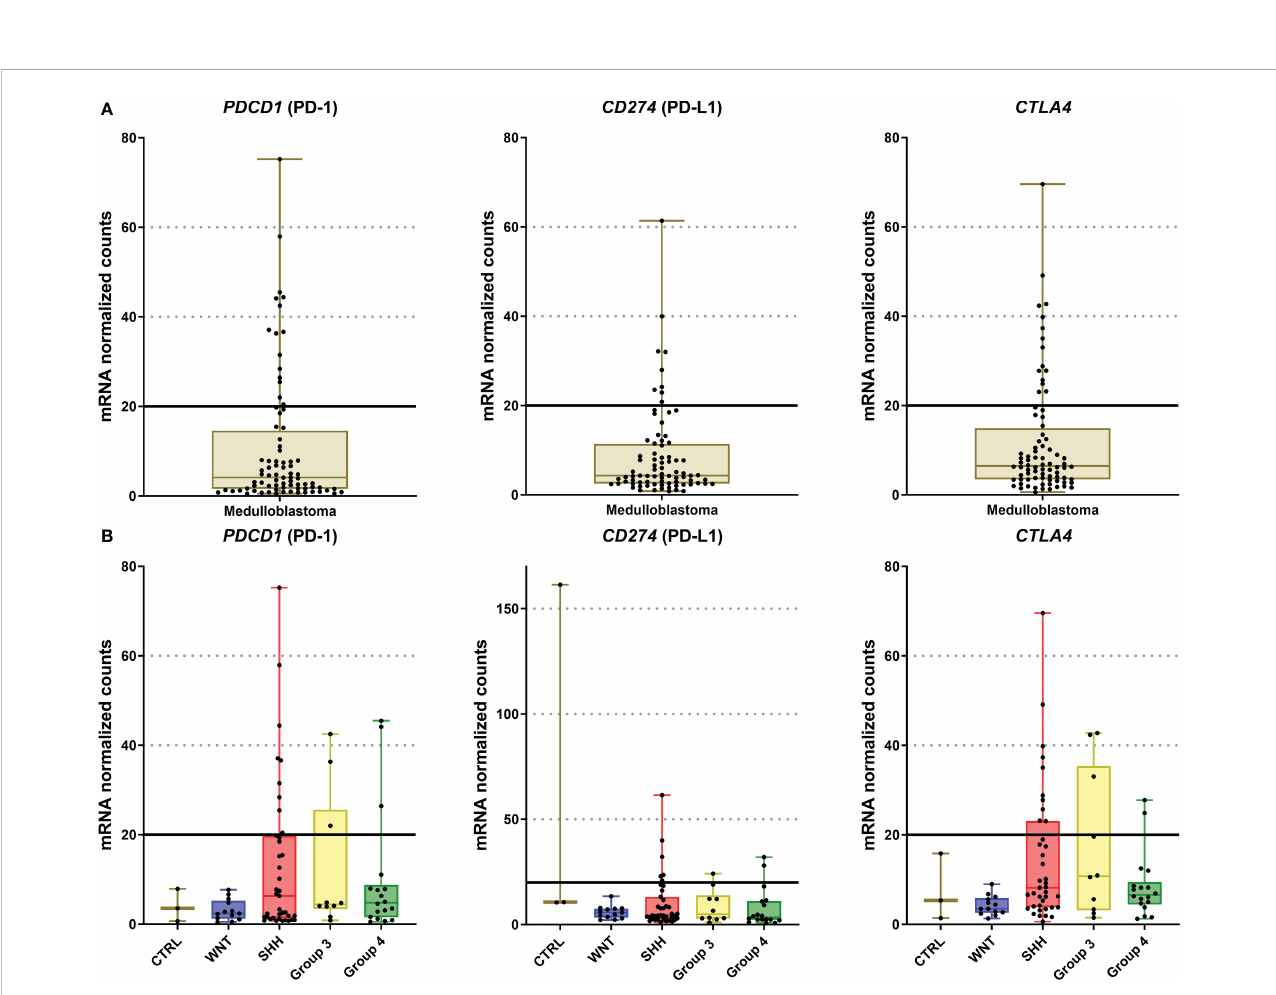
FIGURE 2 Graphic representation of PDCD1, CD274, and CTLA4 mRNA levels of the 80 medulloblastomas analyzed by nCounter. (A) The plot of mRNA levels of all medulloblastomas for PDCD1, CD274, and CTLA4; (B) Plot of PDCD1, CD274, and CTLA4 mRNA levels by medulloblastoma molecular subgroups. The continuous line in each graph marks the background threshold of 20 mRNA normalized expression counts. The plots were obtained through GraphPad Prism